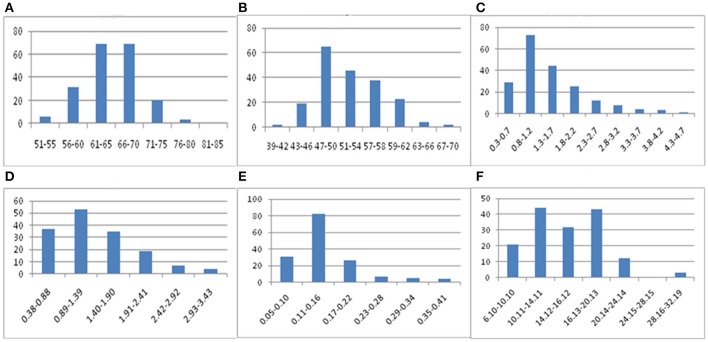
Frequency distribution of flax fiber related traits. (A: plant height; B: stem length; C: seed yield; D: stem yield; E: fiber yield; F: fiber content).